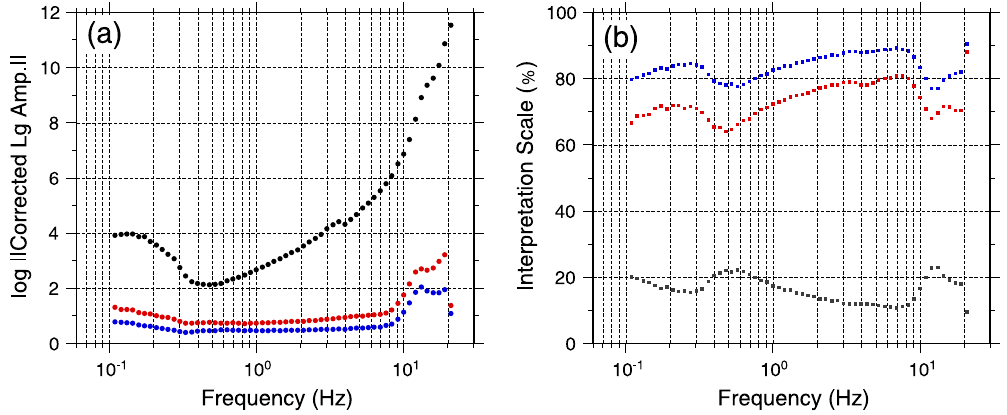
Figure 5. ( a ) All 58 corrected Lg amplitudes at individual frequencies, including the amplitudes corrected by the geometric spreading functions (black dots), the residuals removing both the source term and path Q (red dots), and final residuals removing the source term, Q and site response (blue dots). ( b ) The interpretation scales at 58 frequencies. Interpretation scale is the ratio of estimated amplitude to observed